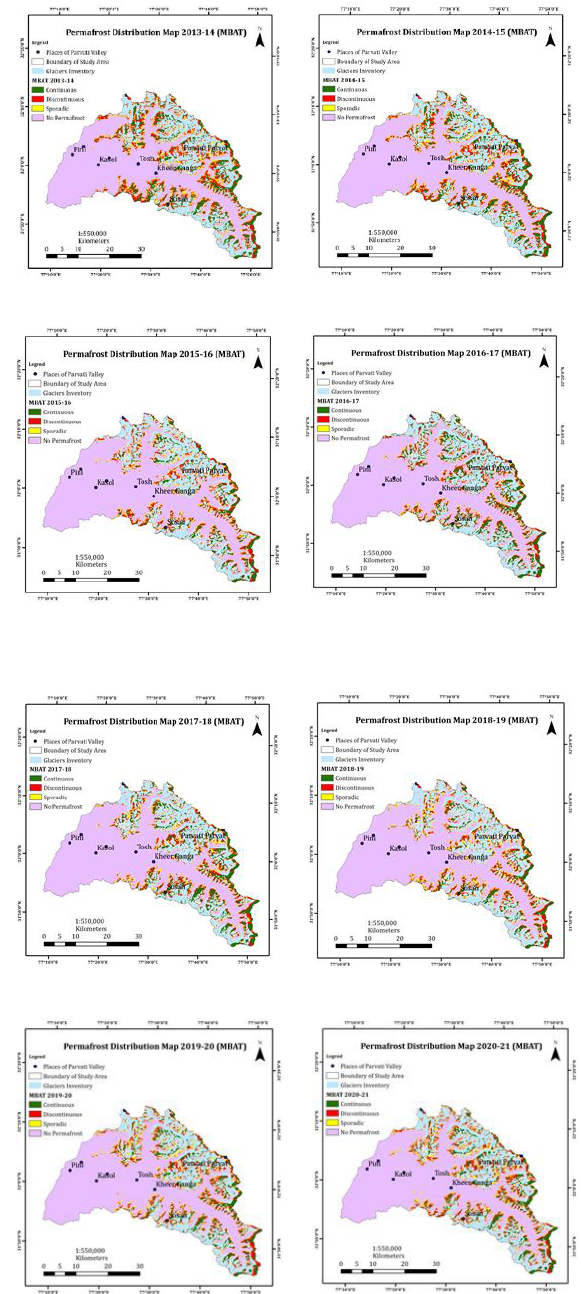
Figure 3: Maps of study area showing the distribution of Continuous, Discontinuous, and Sporadic Permafrost with Glacier boundary using the MBAT (Mean Biennial Air Temperature) from the year 2013 to 2021. Each Maps represent the Permafrost distribution of map of each two consecutive years starting from 2013 to